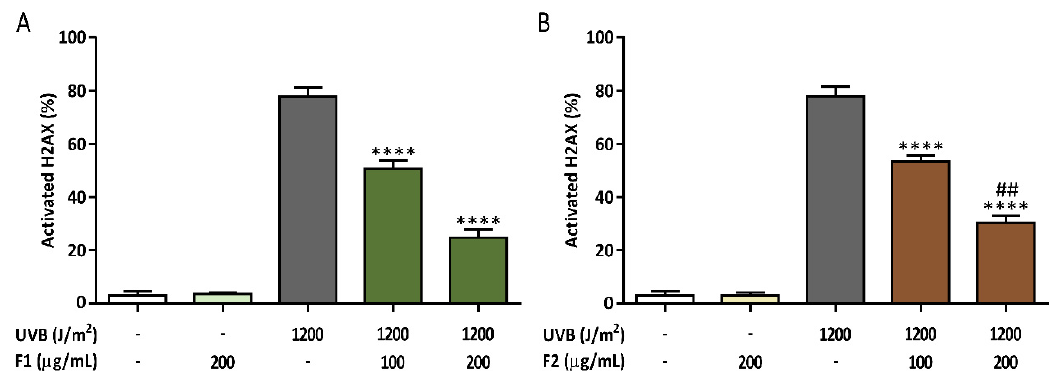
Figure 8. Formulations F1 ( A ) and F2 ( B ) decreased the DNA damage response in UVB-irradiated HaCaT cells by reducing H2AX histone activation. The data are expressed as the mean ± SD. **** ( p < 0.0001) indicates significant differences compared with the irradiated nontreated control, while ## ( p < 0.01) indicates significant differences between irradiated cells treated with the other formulation at the same concentration. Representative population plots are shown in the Supplementary Information, Figure S1.